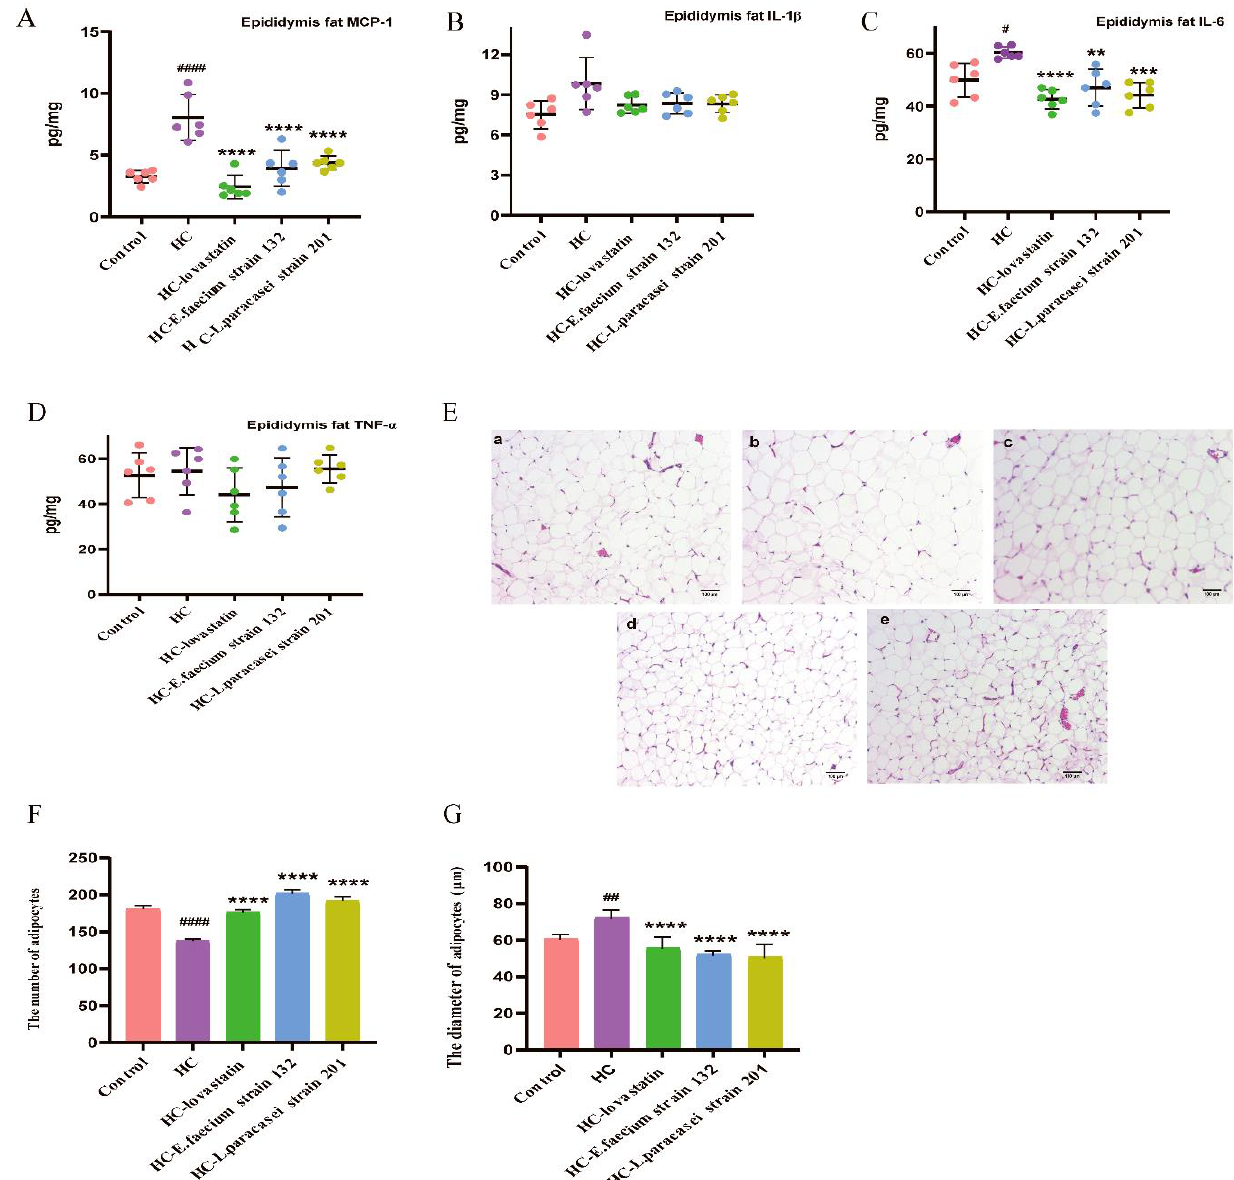
Figure 3. Screening strains improved the inflammation of epididymis fat and fatty hypertrophy in hypercholesterolemia rats. ( A ) The level of epididymis fat MCP-1. ( B ) The level of epididymis fat IL-1β. ( C ) The level of epididymis fat IL-6. ( D ) The level of epididymis fat TNF-α. ( E ) H&E staining of epididymis adipose; (a) control group, (b) HC group, (c) HC-lovastatin group, (d) HC- E. faecium strain 132 group, (e) HC- L. paracasei strain 201 group. ( F ) The number of adipocytes in the same field, ( G ) the diameter of adipocytes in the same field. p -values were determined using a one-way ANOVA with Tukey’s test for post-hoc analysis, n = 6. Significant differences between the HC group versus control group are indicated as # p < 0.05, ## p < 0.01, #### p < 0.0001. Significant differences in the HC-lovastatin, HC- E. faecium strain 132 or HC- L. paracasei strain 201 group versus HC group are indicated as ** p < 0.01, *** p < 0.001, **** p < 0.0001.